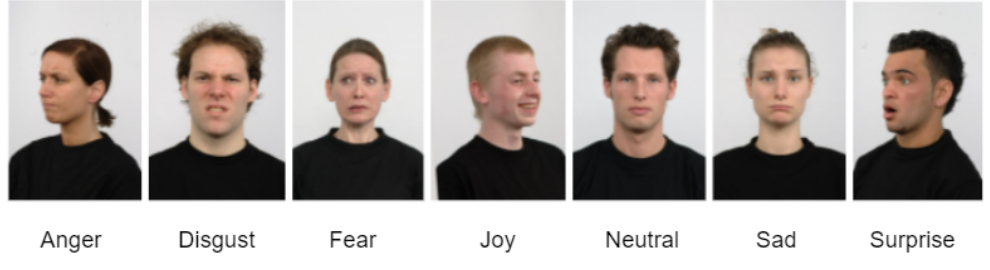
Figure 3. Radboud samples.